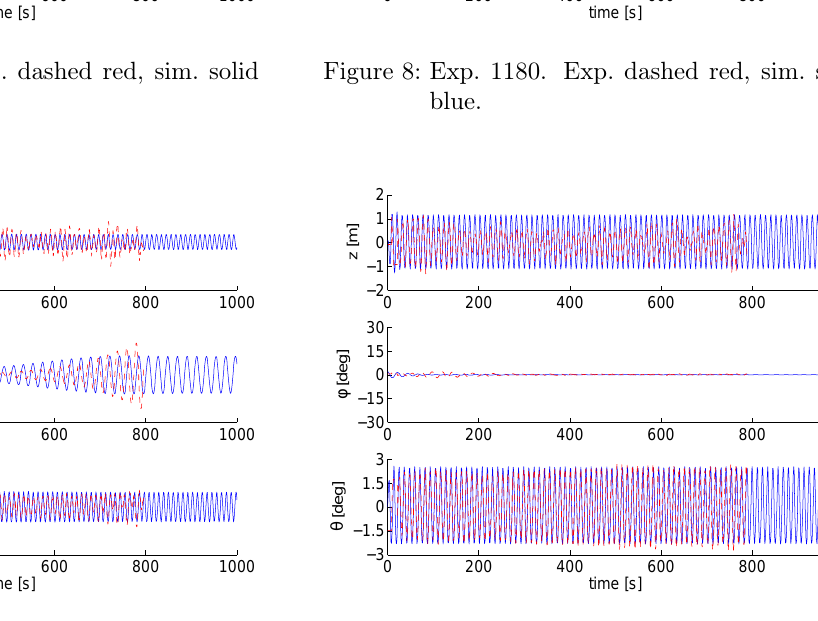
Figure 9: Exp. 1178. Exp. dashed red, sim. solid blue.